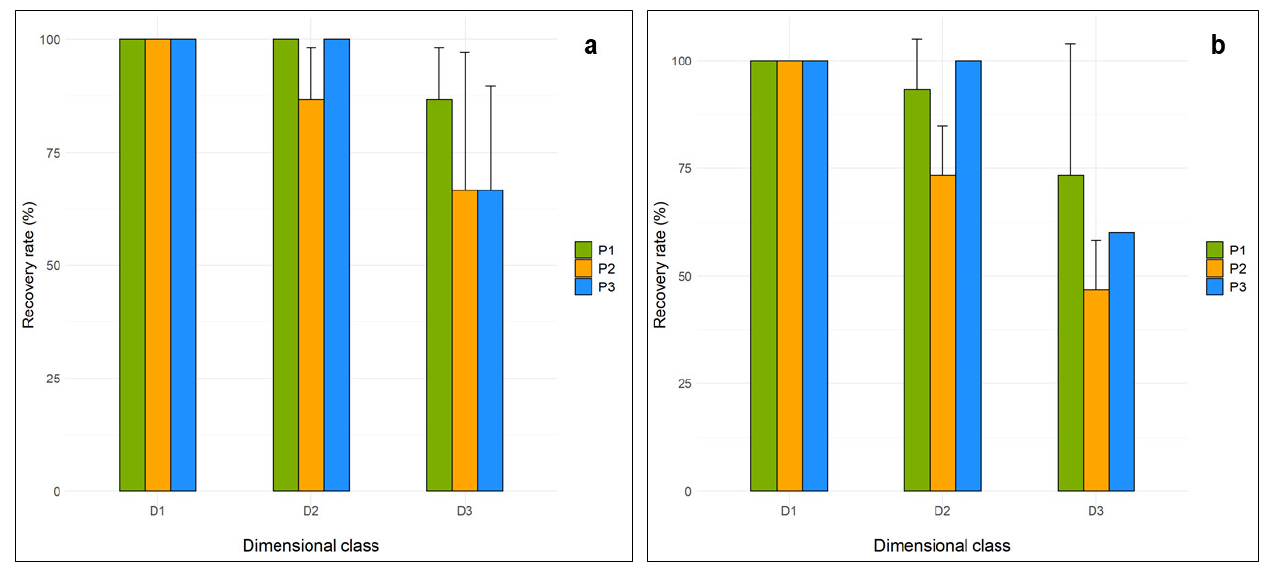
Figure 1. Percentage recovery rate of ( a ) Nylon and ( b ) PET particles for the three protocols testes (P1, P2, P3) grouped by the different dimensional classes (D1: 2–5 mm; D2: 500–2000 µm; D3: 500–250 µm).